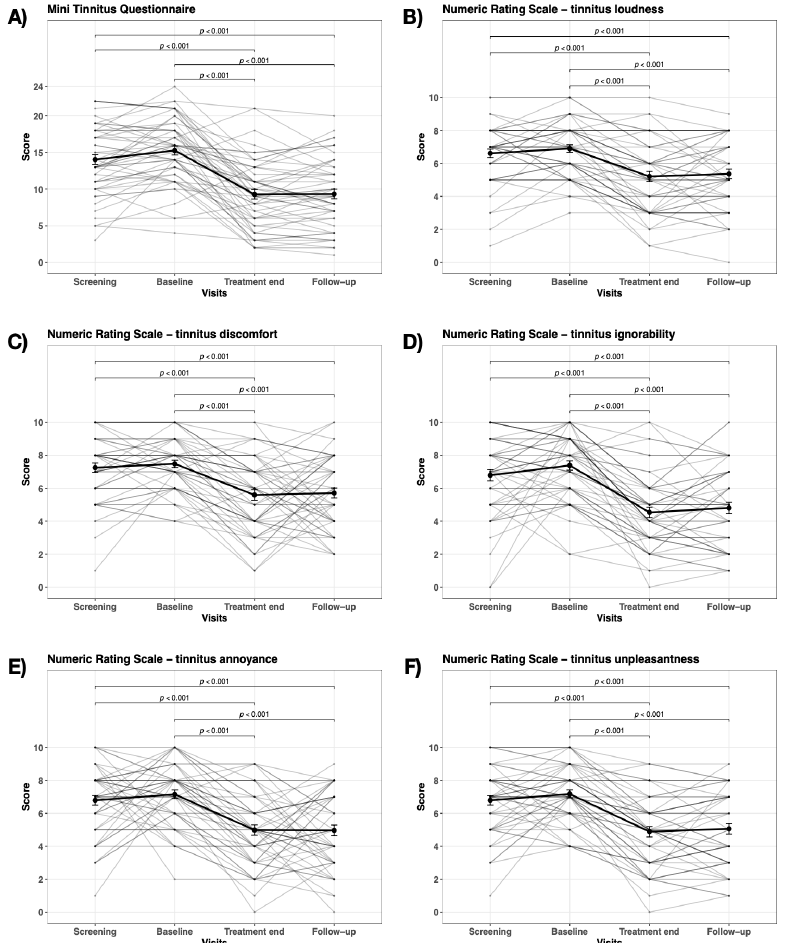
Figure 2. Changes in the tinnitus ratings. Changes in the tinnitus ratings over the four visits with cognitive behavioral therapy taking place between the baseline and the treatment end for the different measures of the tinnitus burden.